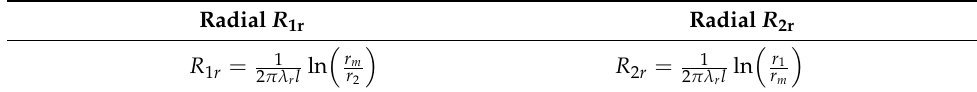
Table 3. Thermal resistance definition of “I” type [6].